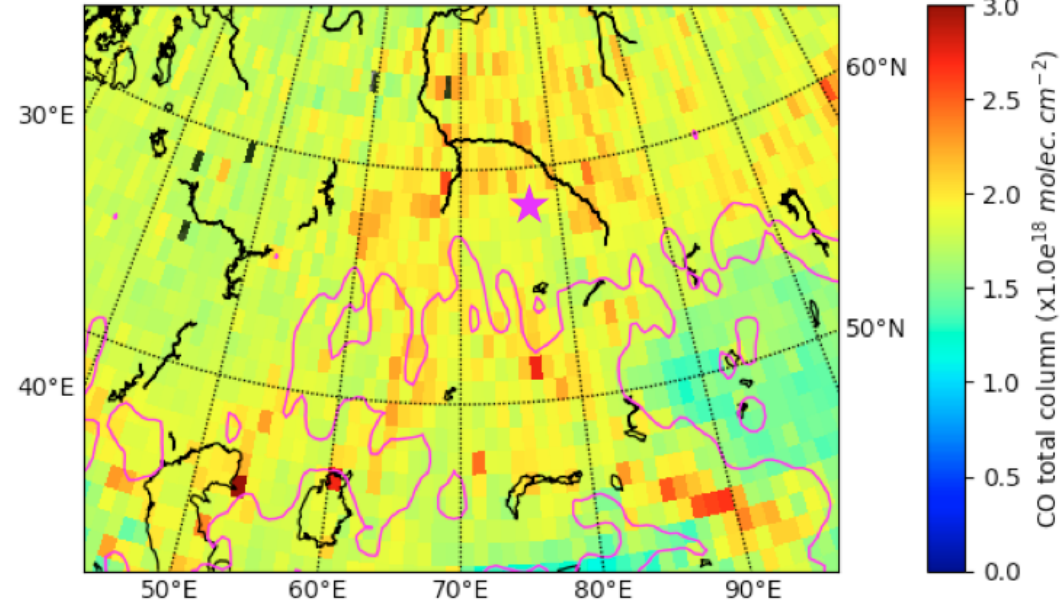
Figure 9. As Figure 5a for the time period 13–16 June 2017.